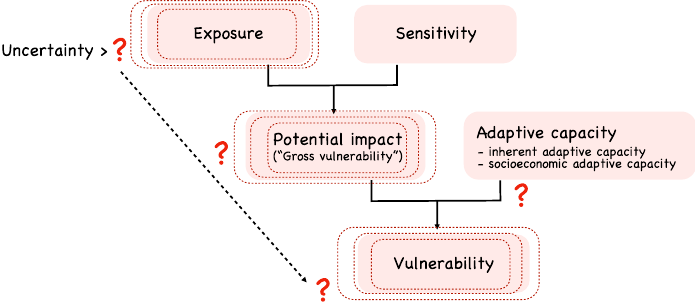
Figure 1. Standard framework of the exposure–sensitivity–vulnerability concept 4–6 . The potential impact (or “gross vulnerability”) of a system is determined by exposure to changing environments as well as by sensitivity of the system itself. The vulnerability is defined as potential impacts alleviated by the adaptive capacity of the system. Uncertainty is ubiquitous in each of the elements in this